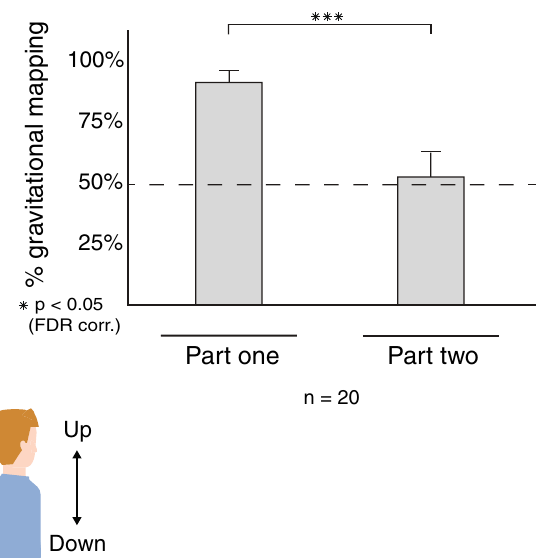
Figure 3. Group analysis on the average proportion of responses matching a gravitational-based tactile to visual mapping (bars indicate the standard error; dashed line indicates chance level). There was a significant difference in the mapping preferences between part one and part two. Thus, switching postures change participants’ mapping of touch to the visual